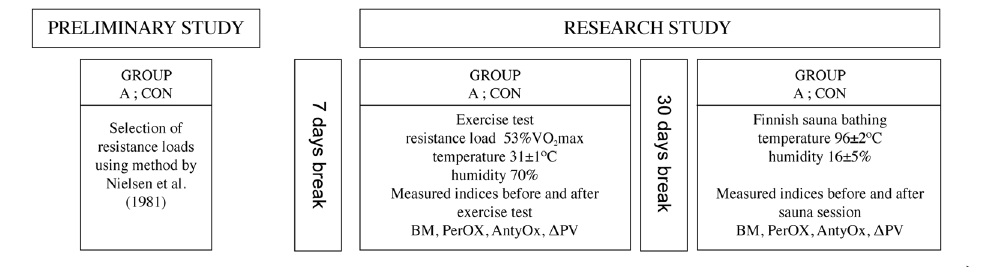
Figure 1. Study design.